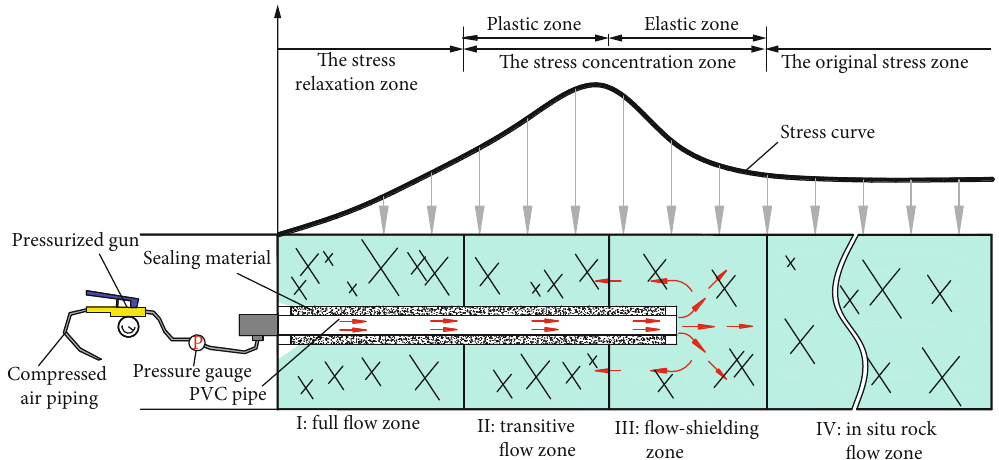
Figure 1: Width measurement system of stress relief zone on roadway surrounding rocks based on the pressure attenuation method.